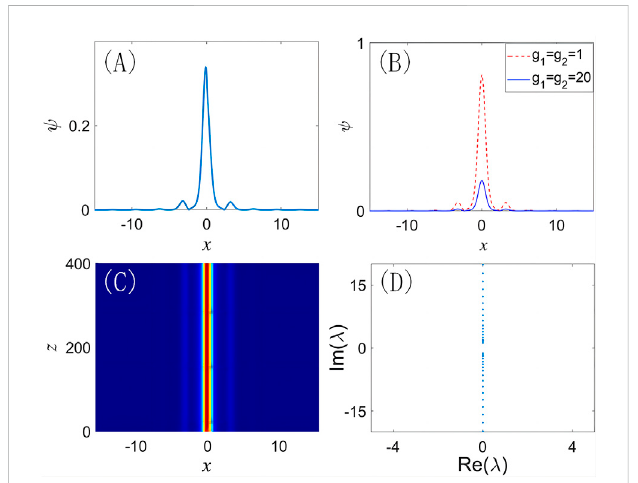
FIGURE 3 (Color online) Second-gap localized modes under propagation constant β (cid:1) − 3 . 5. (A) Intensity pro fi les of unstable localized mode in non-uniform nonlinearity. (B) Pro fi les of localized modes supported by one-dimensionalphotoniclatticesanddifferentconstantnonlinear types (the red dotted line and blue dash line are uniform nonlinearities with nonlinear coef fi cients of 1 and 20 respectively). (C) Evolution of the